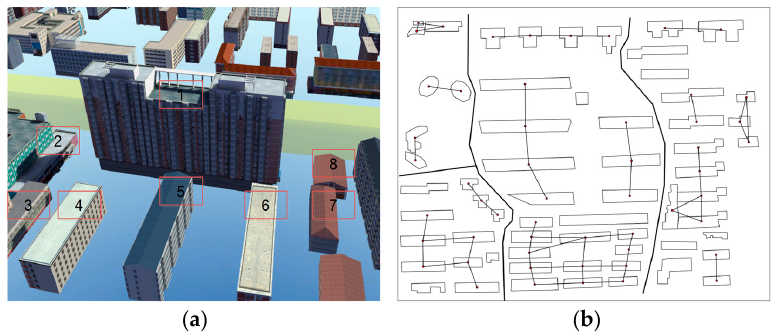
Figure 10. Landmark detection: ( a ) proximity relationship; ( b ) graph from landmark detection.